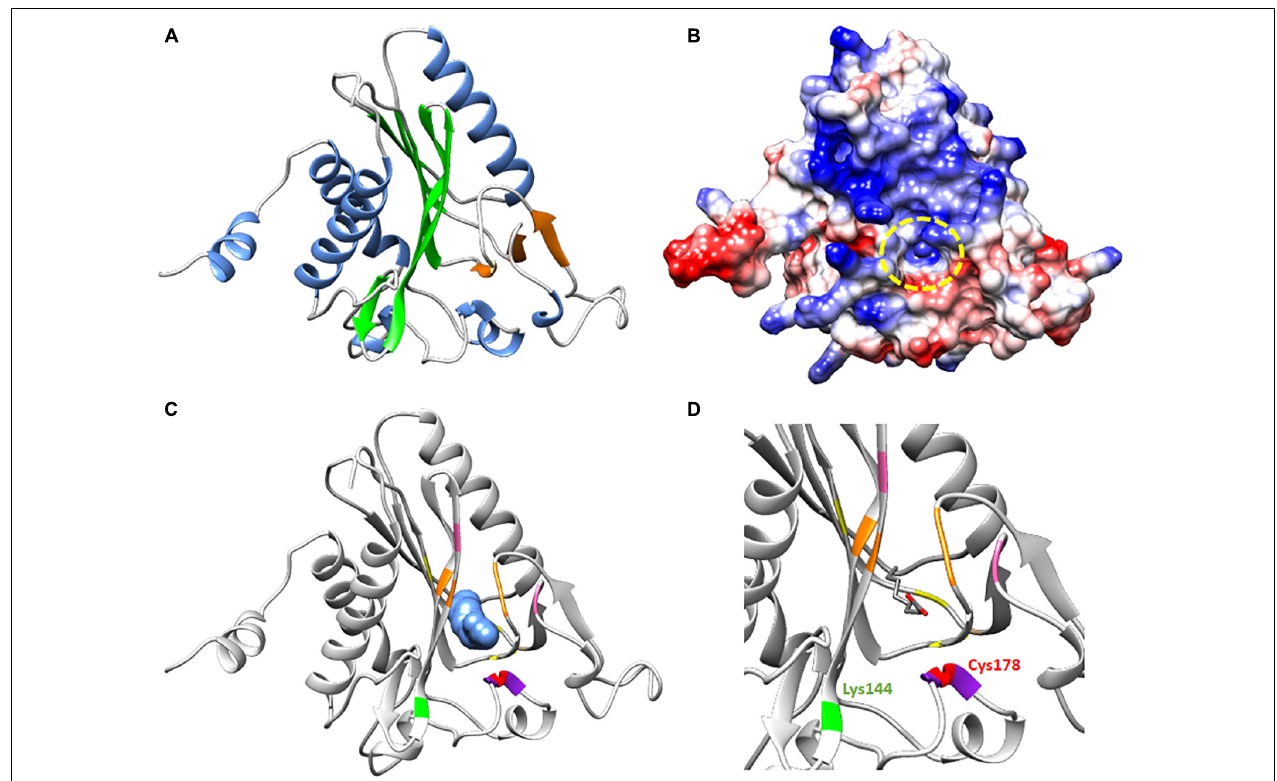
FIGURE 5 | Proposed structure and molecular docking model for Ha LIP2m. (A) Tertiary structure. The core consisted of two β sheets (a minor β sheet in orange and a large β sheet in green). The secondary structure elements with α helix motif are in blue. (B) Coulombic surface coloring showing the gap where the octanoyl chain interacts. (C) Ribbon diagram with the octanoic acid substrate in a 3D view next to the Cys residue (in red and forming part of the purple PCG motif). The Lys residue involved in acyltransferase activity with Cys/Lys is in green and the conserved Gly residues forming the gap in the core structure are in orange. The positively charged residues that participate in the interaction with substrate are marked in pink and the aromatic residues also involved in the interaction with the substrate are in yellow. (D) Wider angle of the active center of the protein with the substrate in a ribbon